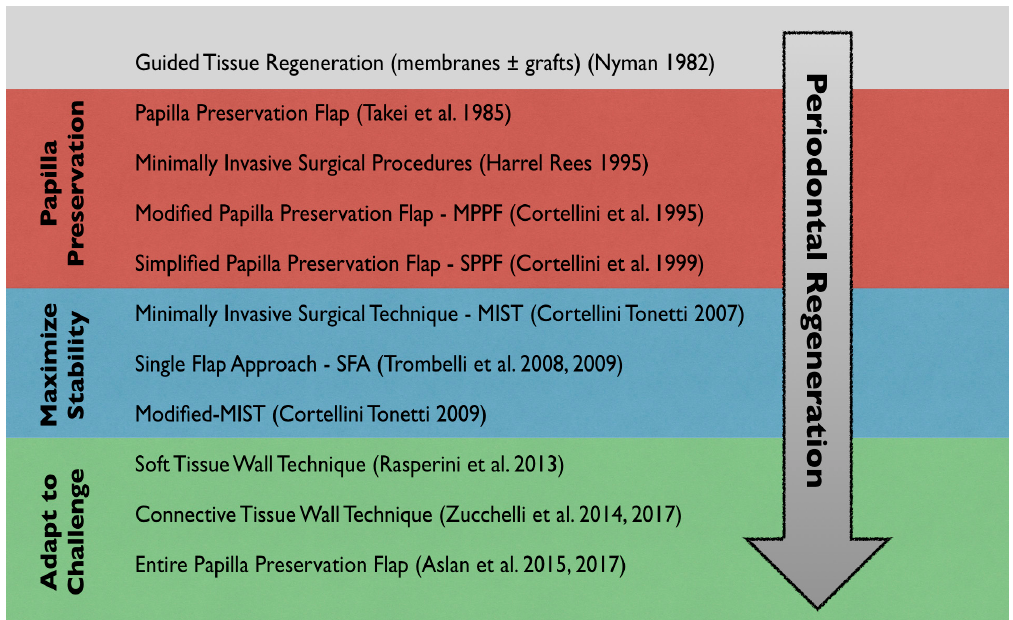
Figure 1. Evolution of flap designs for periodontal regeneration in relation to biological and clinical concepts.